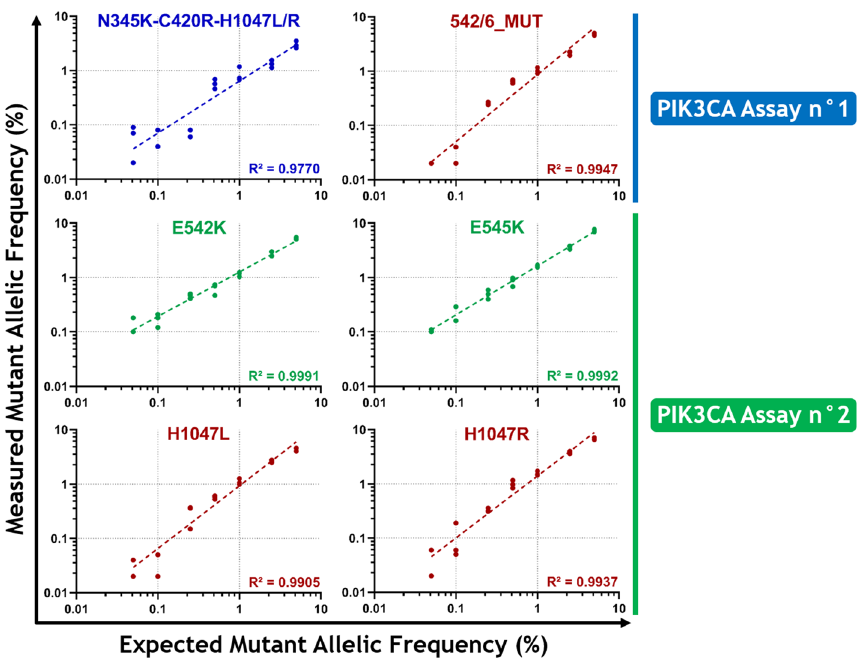
Figure 3. Evaluation of the sensitivity of the PIK3CA assays. DNA mixes were prepared through serial dilutions of MUT gBlocks in a constant WT gDNA background of 10,000 copies/PCR to reach theoretical MAF of 5%, 2.5%, 1%, 0.5%, 0.25%, 0.1% and 0.05%. The PIK3CA Assay n°1 mixes included the four MUT gBlocks of the N345K-C420R-H1047L/R detection and the eight most frequent mutations identified on codons 542–546 ( MAF: mutant allelic frequency )